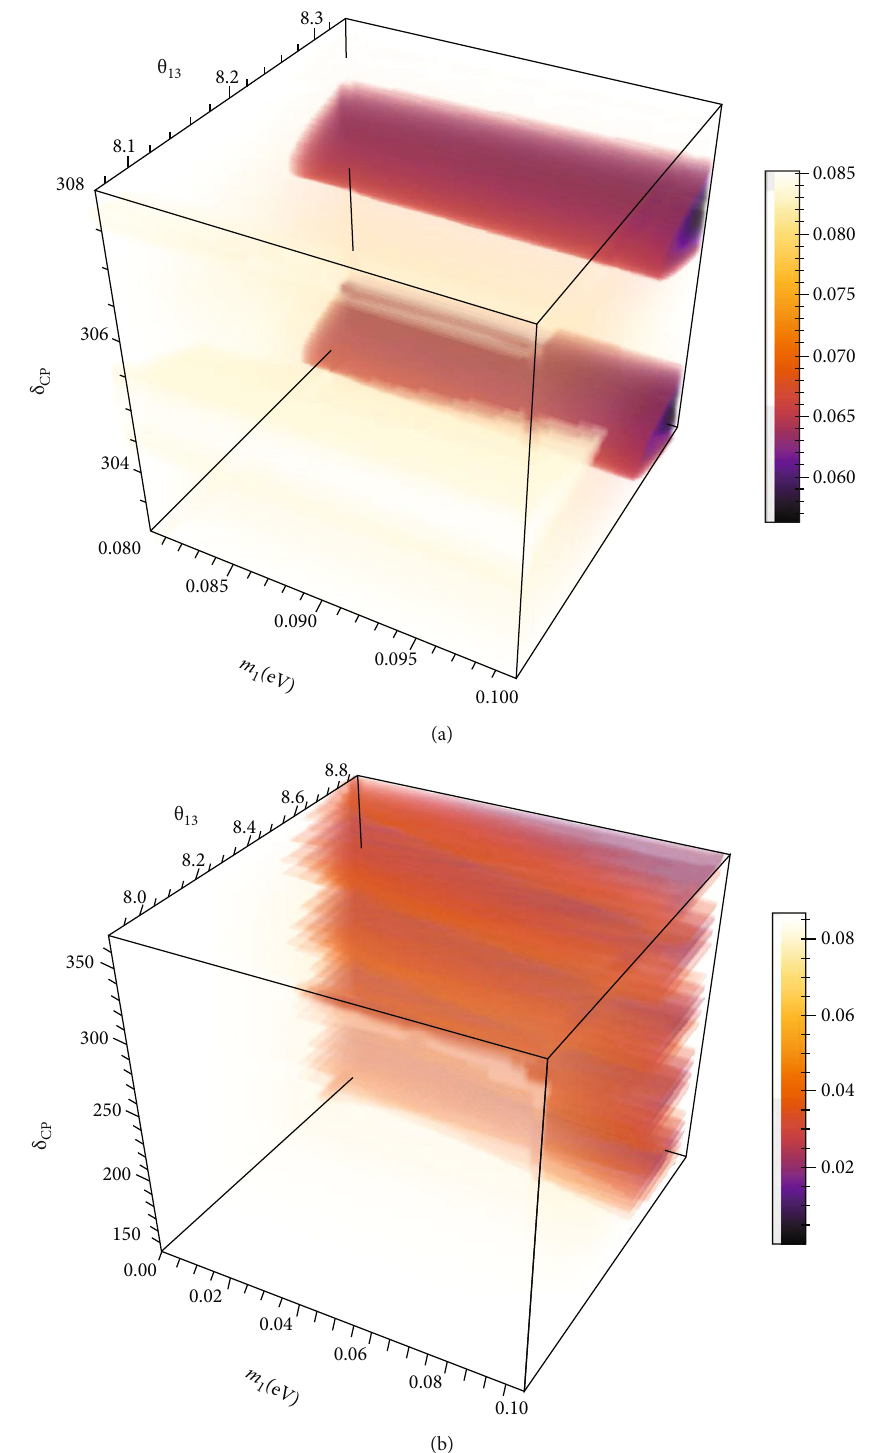
Figure 11: Predictions in the broken μ − τ symmetry model for normal ordering: (a) depicts predicted three-dimensional space of Þ for m ð m , δ , θ [eV], 0 νββ decay for favoured values of m 1 CP 13 ee density bounds, 5 : 8 × 10 − 10 < η < 6 : 6 × 10 − 10 ). (b) Depicts the predicted three-dimensional space of ( m decay for values of m , δ , and θ in the given three σ range, corresponding to Δχ 2 = 6 : 2 and Δχ 2 = 9 : 5 w/o SK-ATM 1 CP 13